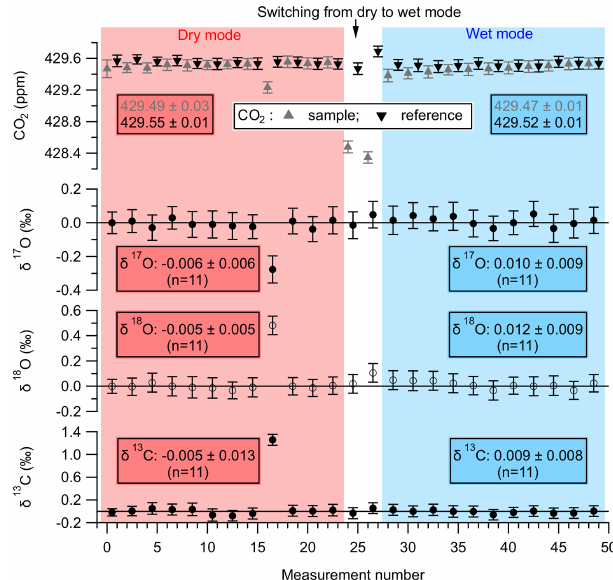
Figure 4. A zero-enrichment experiment performed with the TILDAS-SICAS to test the effect of the NAD on the CO 2 mole fraction and the stable isotopes of CO 2 . The top panel shows the CO 2 dry air mole fraction, where the grey triangles represent the sample measurements and the black inverted triangles represent the reference measurements. The other three panels show the isotopic composition of the sample gas determined with respect to the refer- ence gas. The error bars denote the 1 σ standard deviation of a 60s measurement. The reference gas is identical to the sample gas, with the only difference being that the sample gas was measured after it had passed through the NAD. The first part of the experiment rep- resents the dry mode (shown with a red background), where, for sample measurements, dry air from a cylinder was passed through a preconditioned NAD and was then introduced into the TILDAS- SICAS for measurements. In the latter half of the experiment in wet mode (shown with a blue background), the dry air form the cylinder was first humidified ( ∼ 2% H 2 O) and then dried through the NAD before introducing it into the TILDAS-SICAS for measurements. As can be seen, the NAD does not significantly affect the measure- ments of CO 2 mole fractions and its stable isotope